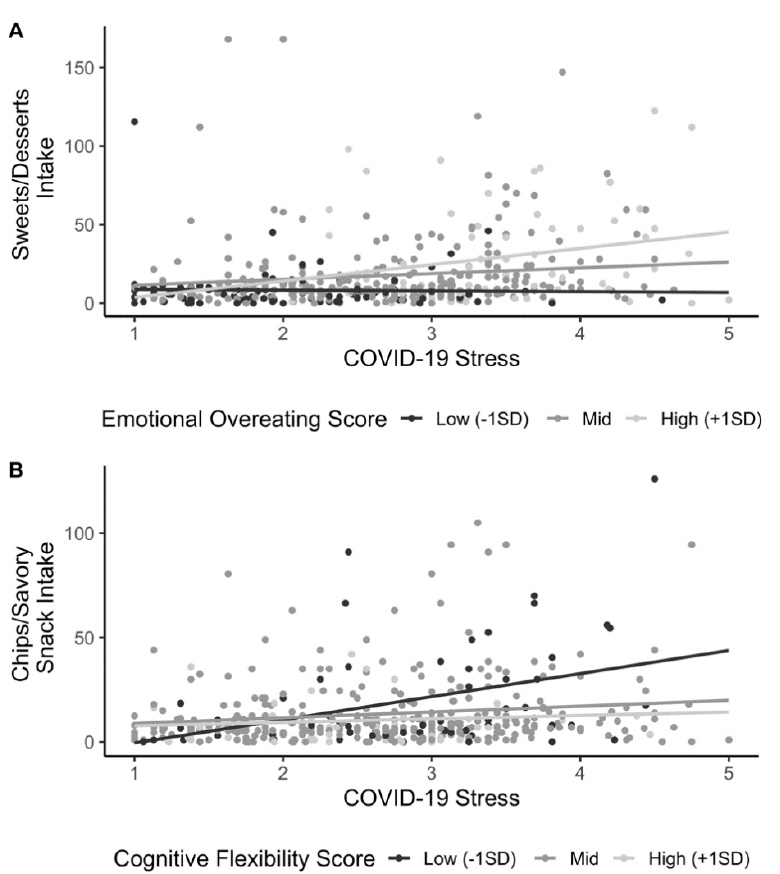
Figure 1. Associations of COVID-19-related stress, emotional overeating, and cogni- tive flexibility with food intake ( n = 428).